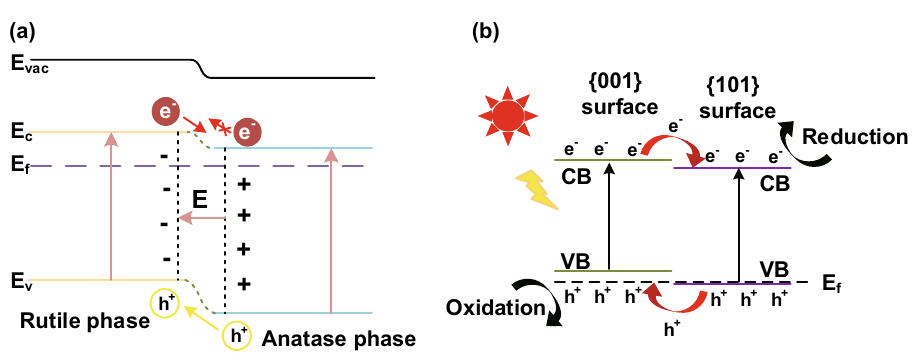
Fig. 11 a Illustrations of the proposed band alignment between rutile and anatase. Reproduced with permission from Ref. [78]. Copyright 2015 Elsevier; b {001} and {101} surface heterojunction. Reproduced with permission from Ref. [77]. Copyright 2014 American Chemical Society